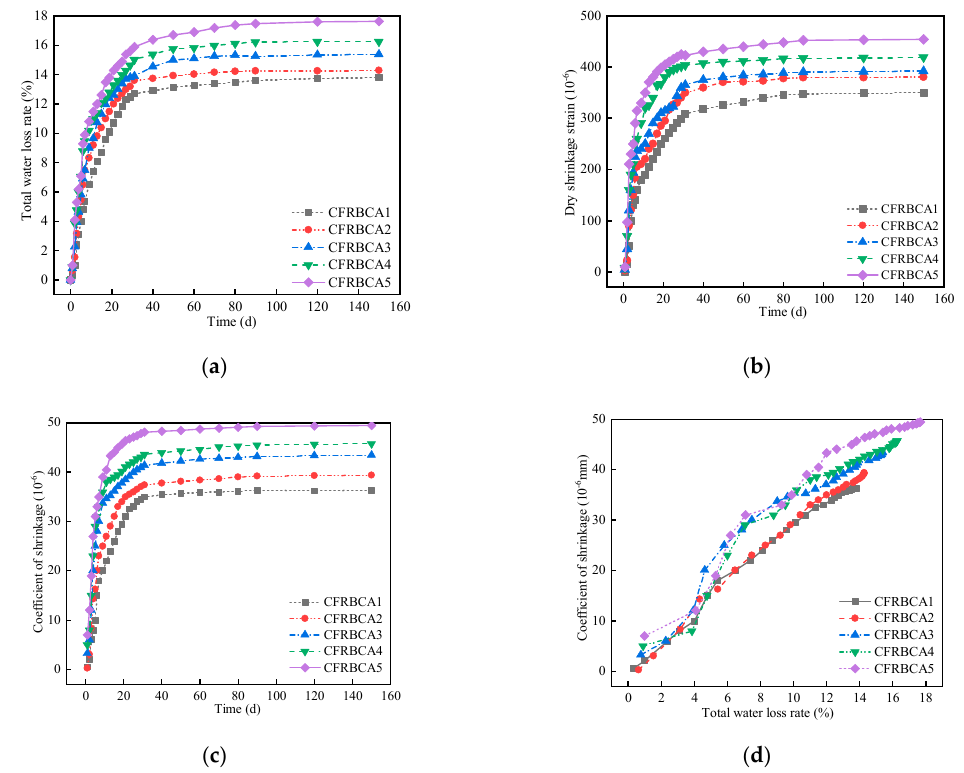
Figure 4. Dry shrinkage test results: ( a ) Relationship between total water loss rate and time, ( b ) Relationship between dry shrinkage strain and time, ( c ) Relationship between shrinkage coefficient and time, ( d ) Relationship curve between shrinkage coefficient and water loss rate.